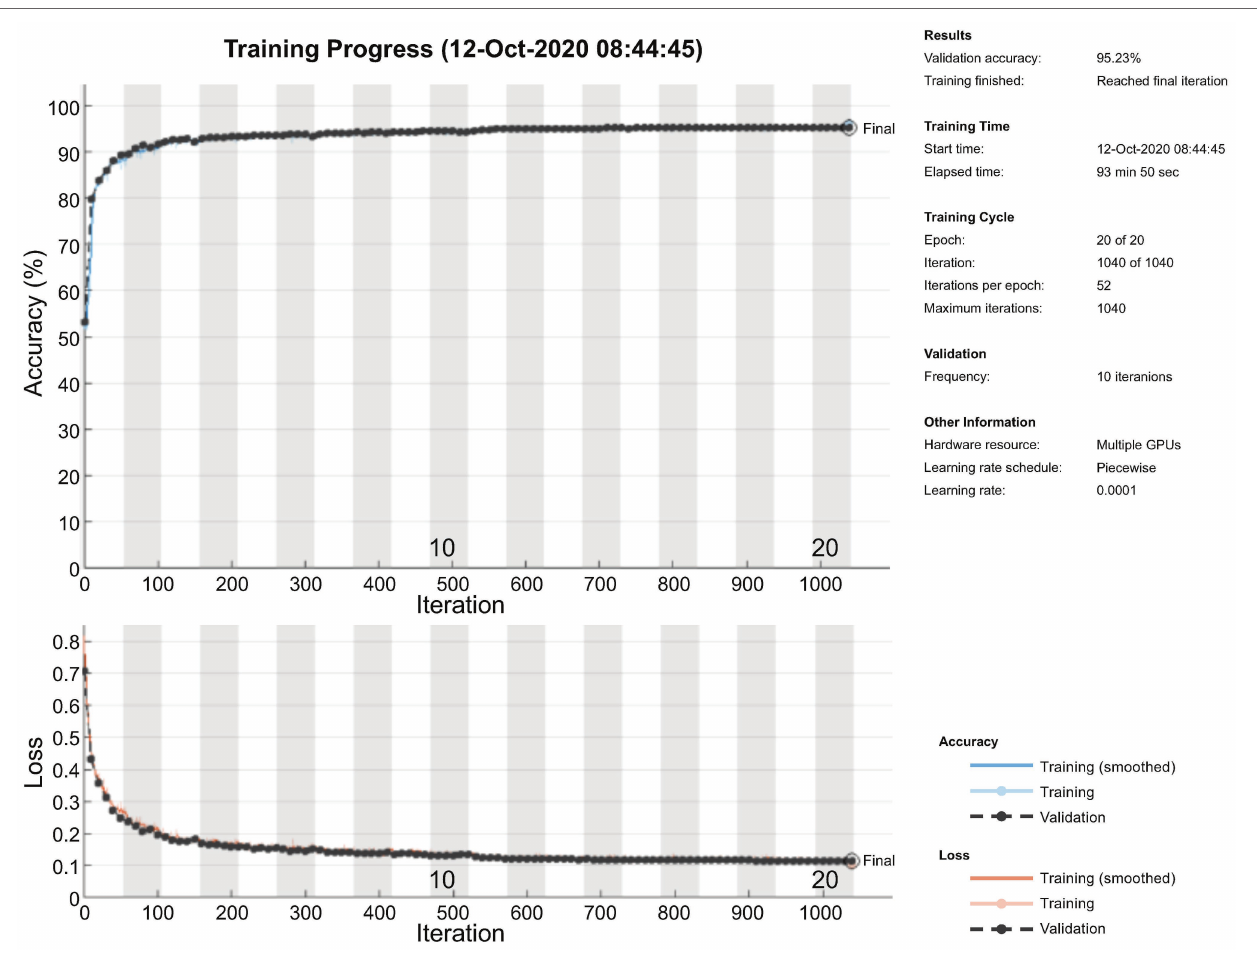
FIGURE 9 | Monitoring of